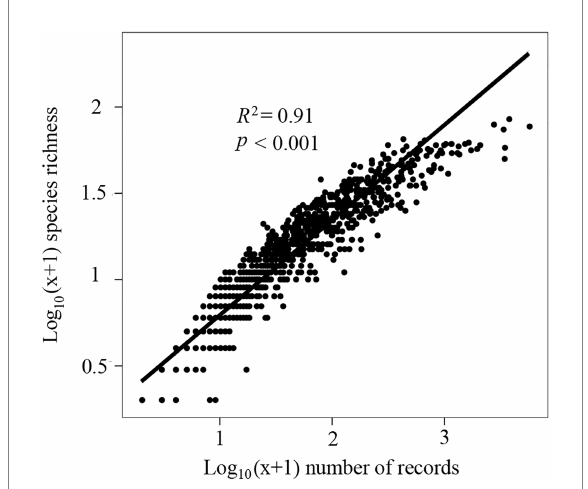
FIGURE 1 Linear regression ( y = 0.55× + 0.243) for log10 (× + 1) transformed number of records and species richness in a 100 × 100-km